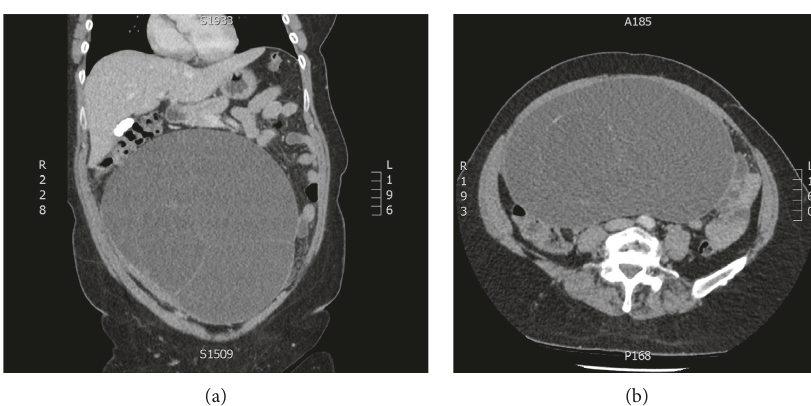
Figure 1: (a, b) CT abdomen showing large septated ovarian mass.